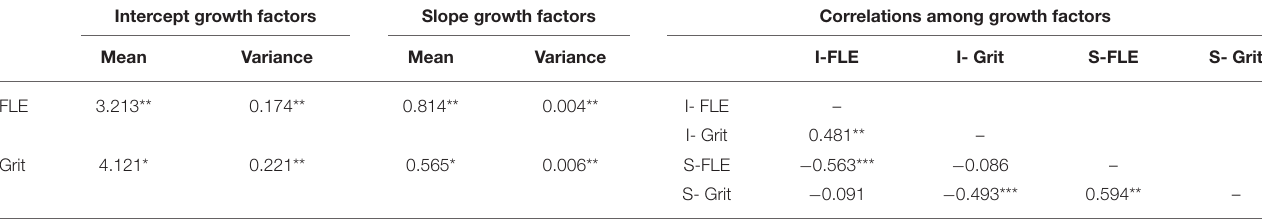
TABLE 3 | Results of the parallel process model